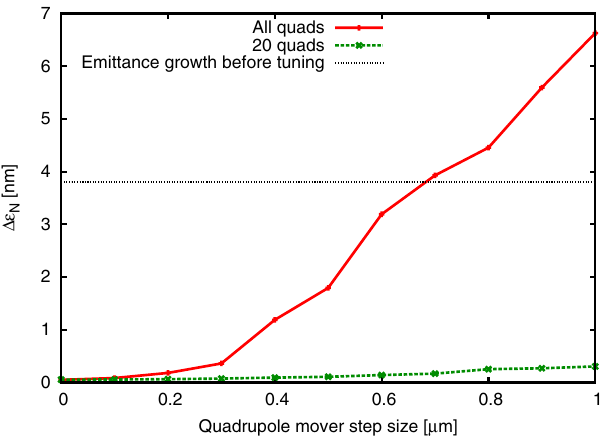
FIG. 26. Convergence of dispersion and wakefield knobs com- pared to convergence of optimal knobs. Even after 50 optimi- zation steps the dispersion and wakefield knobs have not reached the low emittance obtained after four optimization steps with optimal